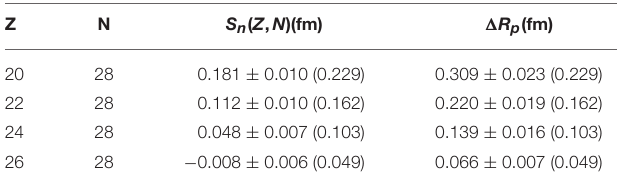
The values in paranthesis are the results without Coulomb contribution (as a verification).